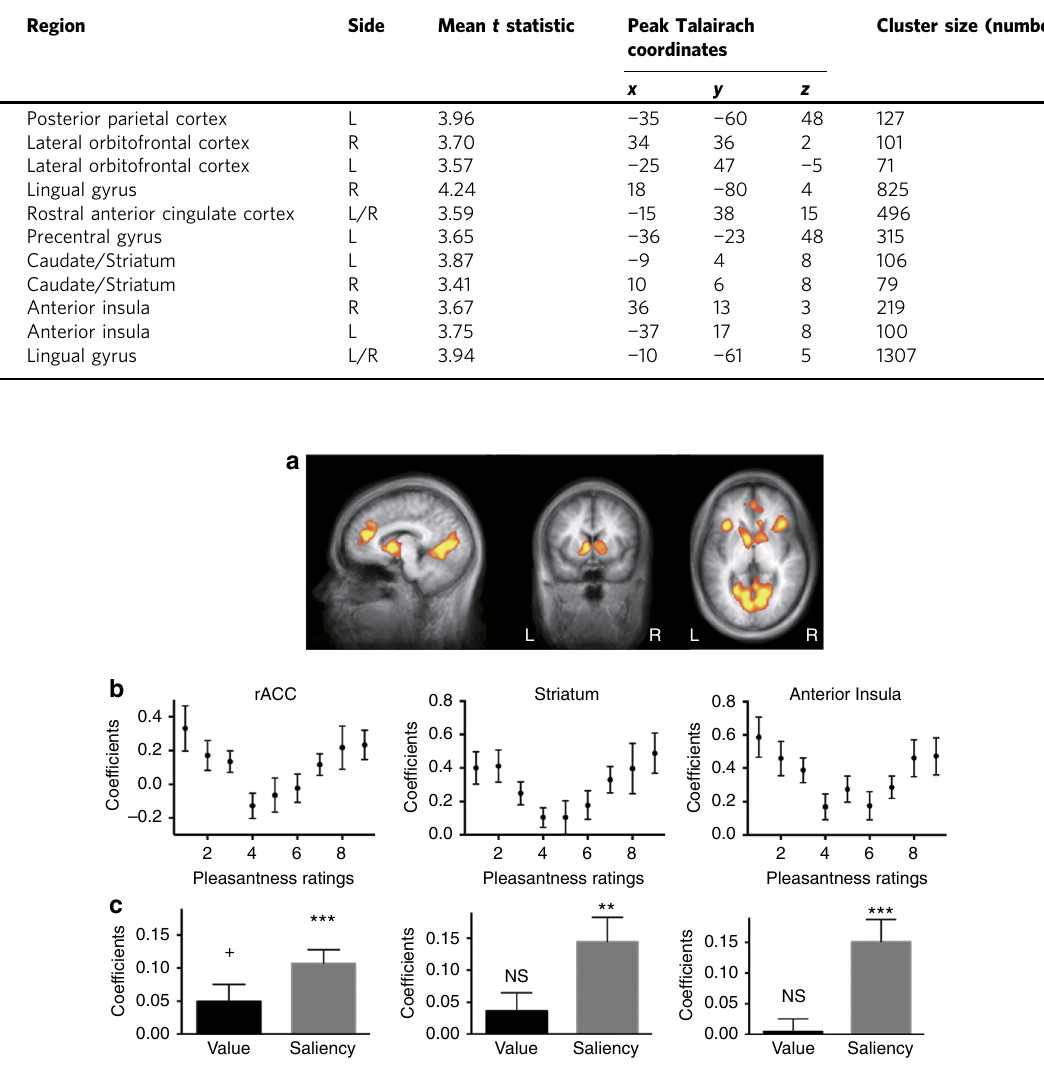
Fig. 1 for the rationale of this approach and potential caveats). We general linear model to compute the contribution of value and saliency signals to the activity of each voxel. We then searched for voxels whose activity was positively correlated with value across participants (Fig. 2a, Table 1; for details, see Methods section). This analysis revealed univariate value signals in the left posterior parietal cortex (PPC; family-wise error rate (FWE) p < 0.05 cluster-size thresholding, threshold = 69 voxels, same below; center Talairach coordinates X = − 39, Y = − 61, Z = 55) and bilat- eral orbitofrontal cortex (OFC; X = − 21, Y = 50, Z = − 5 in the left hemisphere, X = 30, Y = 29, Z = − 2 in the right hemisphere). To